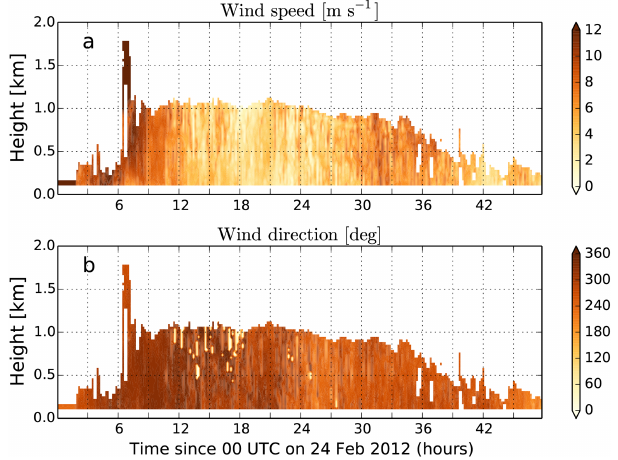
Figure 5. (a) Standard deviation and (b) skewness of vertical veloc- ity. The black shading shows the location of the cloud layer, where cloud base is diagnosed from the lidar measurements and radar mea- surements are used to infer cloud-top height. The black line gives the lifting condensation level estimated from surface temperature and humidity